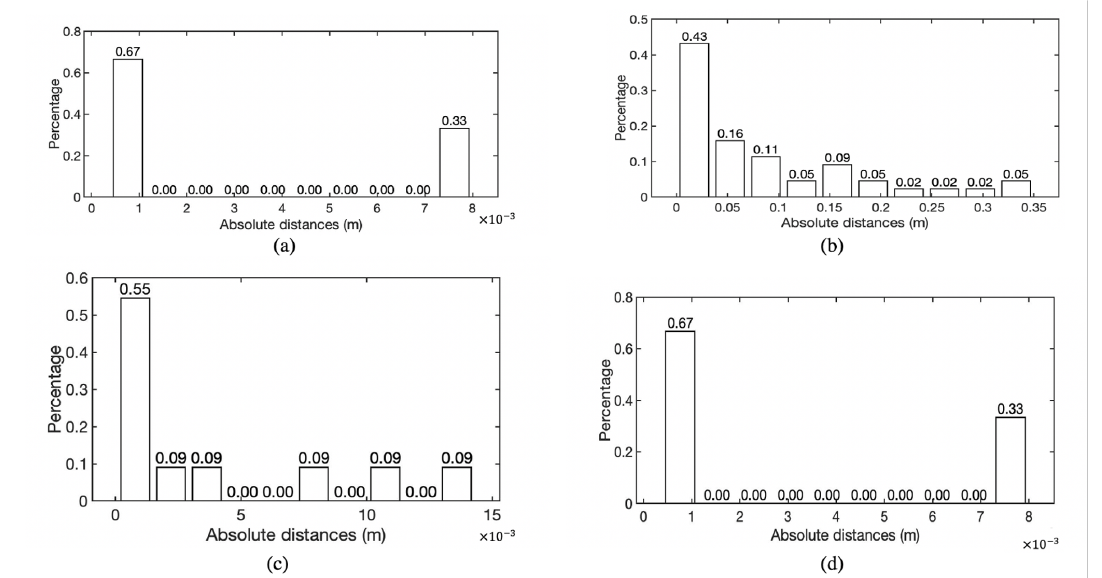
Figure 9. Comparative results of mean error in terms of individual rooms for ( a ) Area 1/2D-3D-S; ( b ) Area 6/2D-3D-S; ( c ) Synth 3; ( d ) Cottage.